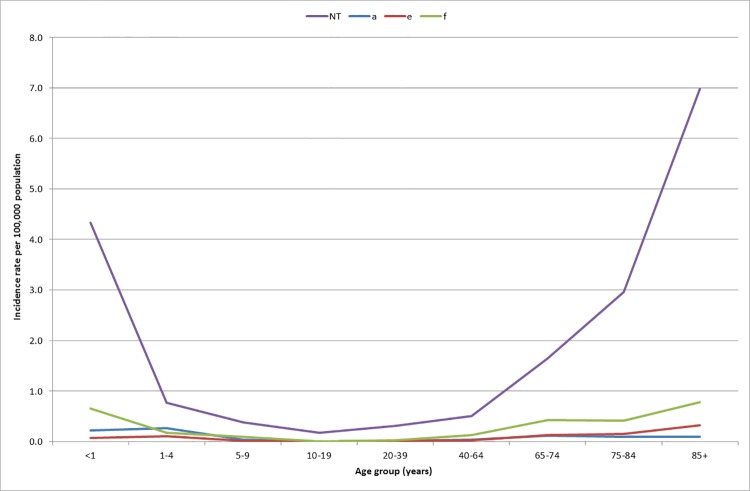
Incidence rate of invasive non-type b Hi by serotype and age group in Ontario, 2004–2013 (n = 1,290).